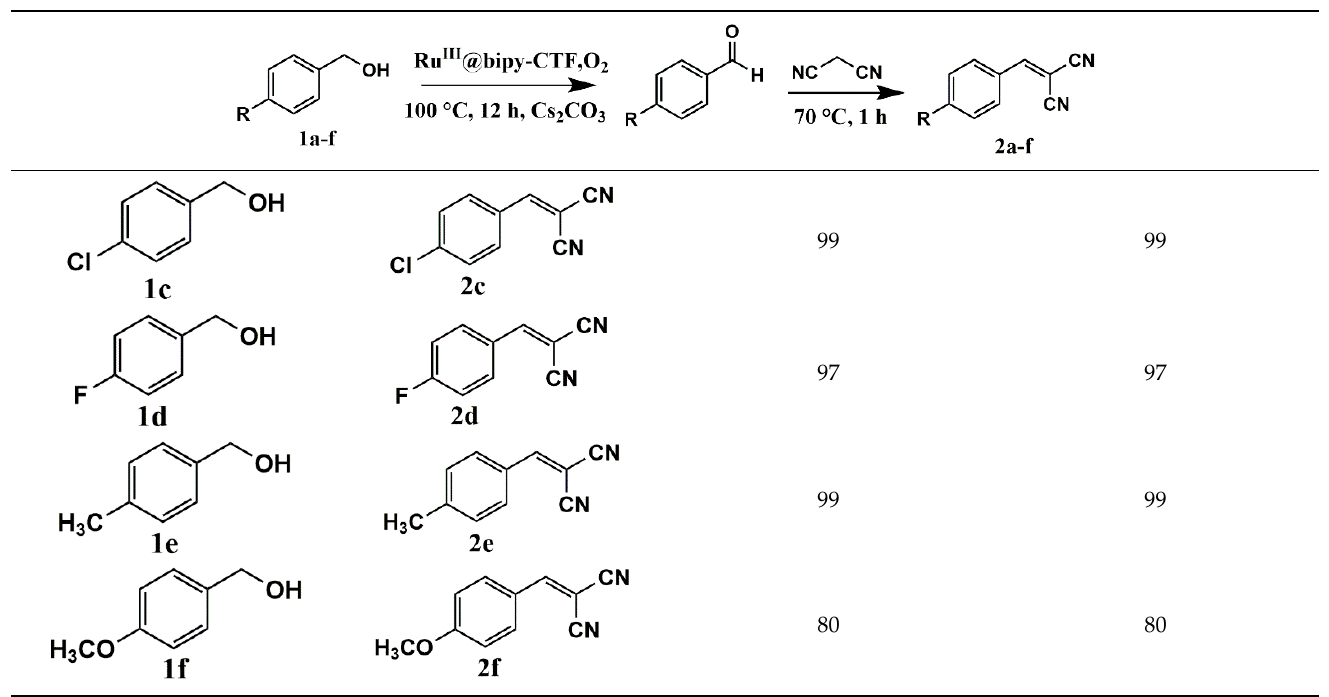
Table 3. Catalytic performance of Ru III @bipy-CTF catalyst in tandem aerobic oxidation–Knoevenagel condensation reac- tion.